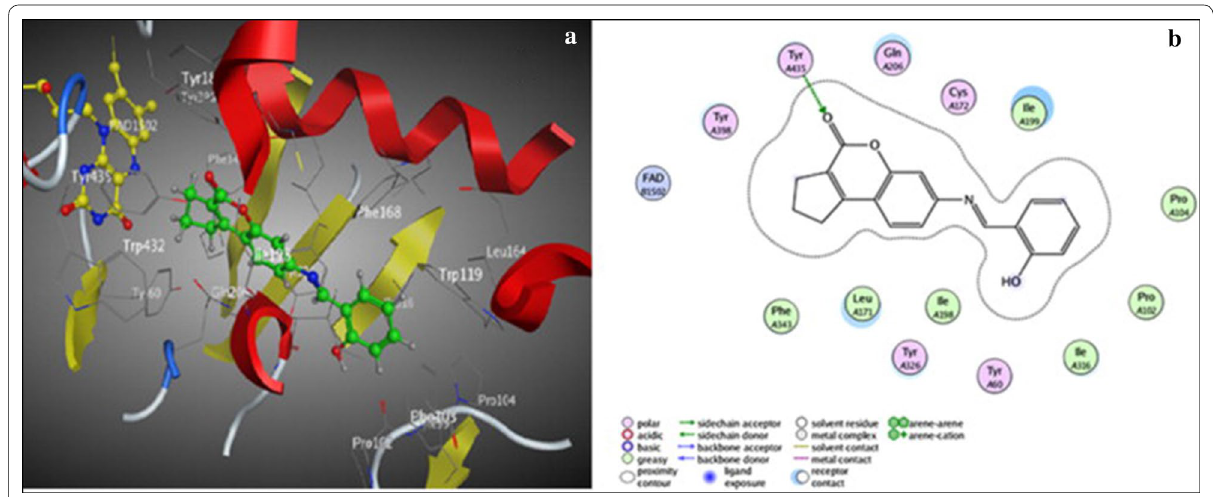
Fig. 82 Molecular docking of C93 with MAO-B ( a , b )